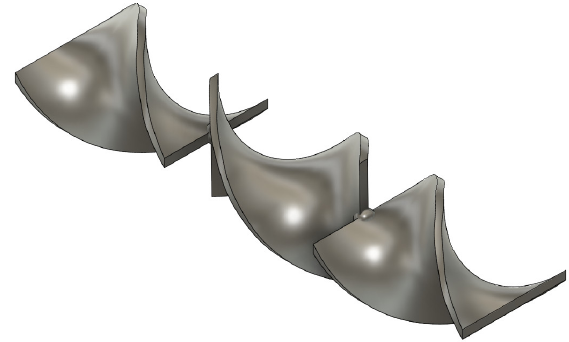
Figure 2. Static mixer model from Autodesk Fusion 360 CAD software .